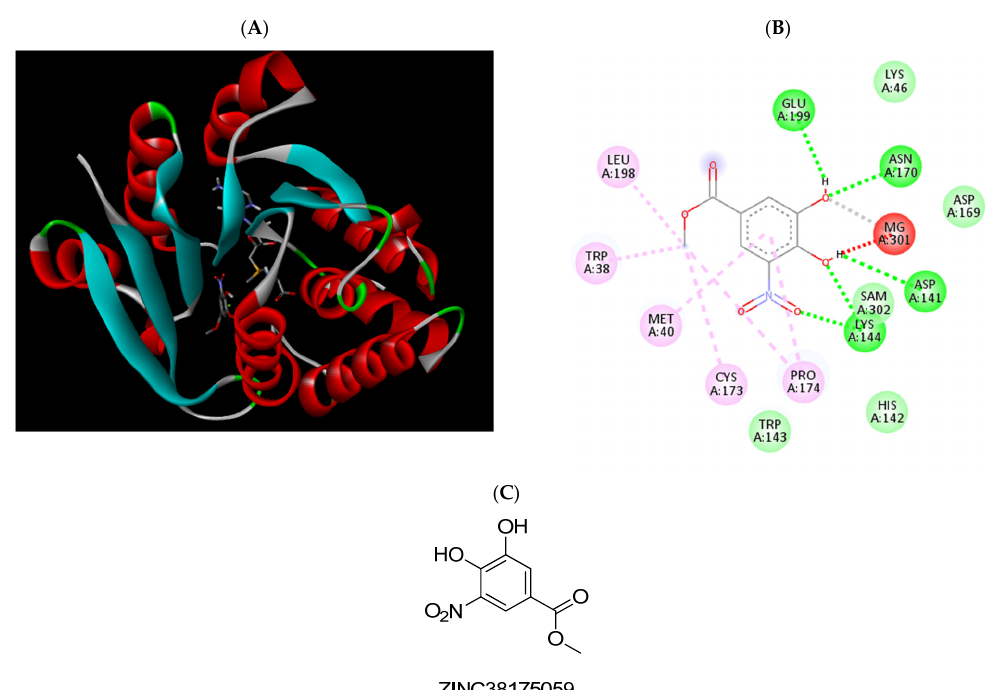
Pharmaceuticals 2022 , 15 , x FOR PEER REVIEW Figure 10. ( A ) Binding modes of ZINC38175059 with the crystal structure of human COMT complexed with SAM and Mg 2+ , ( B ) receptor–ligand interactions, ( C ) 2D representation of ZINC38175059.